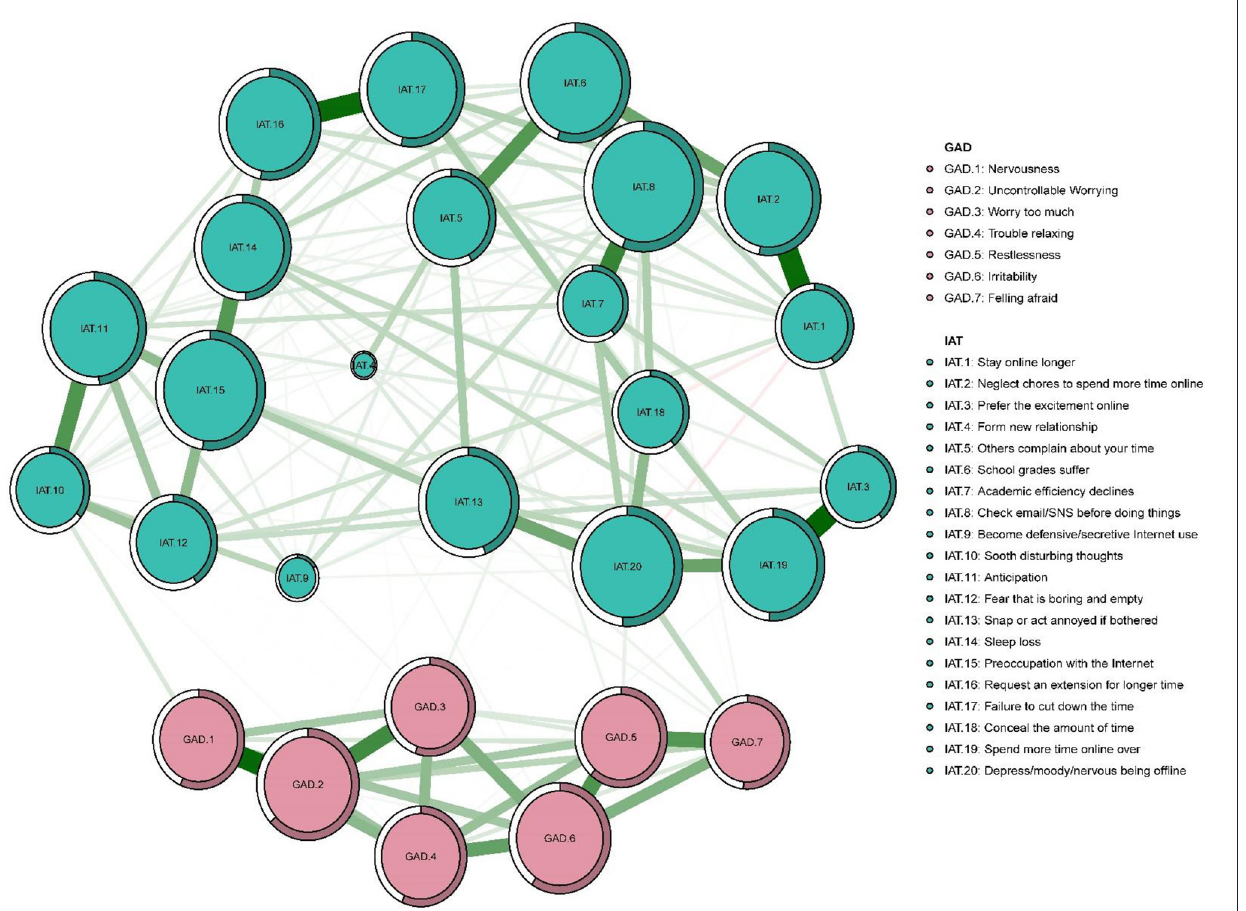
FIGURE 1 | Estimated network model for Internet addiction in nursing students ( n = 1,070). Symptom network of Internet addiction and anxiety symptoms in nursing students in post-COVID-19 pandemic era in China. The survey was conducted between September 14 and October 7, 2020. Ring-shaped pie charts represent predictability (a fully filled dark ring would indicate that 100% of the symptom’s variance is explained by its intercorrelations with the other symptoms in the network). In the diagram symptom node with stronger connections are closer to each other. The green node denotes the IAT items; the pink node denote the GAD-7 items. The dark green lines represent positive correlations. The red lines represent negative correlations. The edge thickness represents the strength of the association between symptom